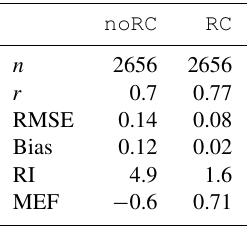
Table 3. Statistical model–data comparison of the two simulations for the whole particle dataset displayed in Fig. 3. The upper ocean has been excluded from the analysis (defined as less than 200m). RMSE, RI, and MEF are, respectively, the root mean square error, the reliability index, and the modelling efficiency (see text for more